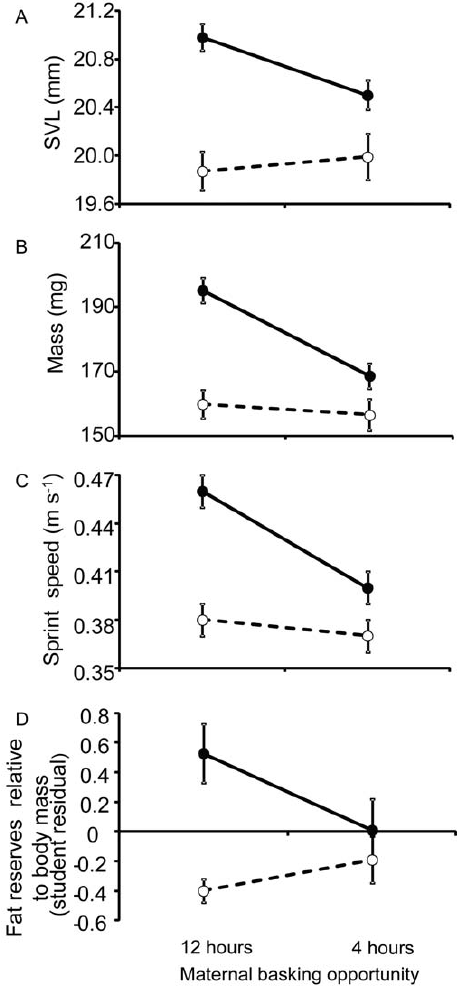
Figure 2. Effects of maternal gestation conditions on offspring Pseudemoiaentrecasteauxii . A: snout-vent length (SVL), B: body mass, C: sprint speed and D: fat reserves relative to body mass at birth from females given combinations of extended and restricted basking N opportunities and food supply during gestation. Values are means 6 : Offspring from females given high food availability during S.E. gestation. # : Offspring from females given low food availability during